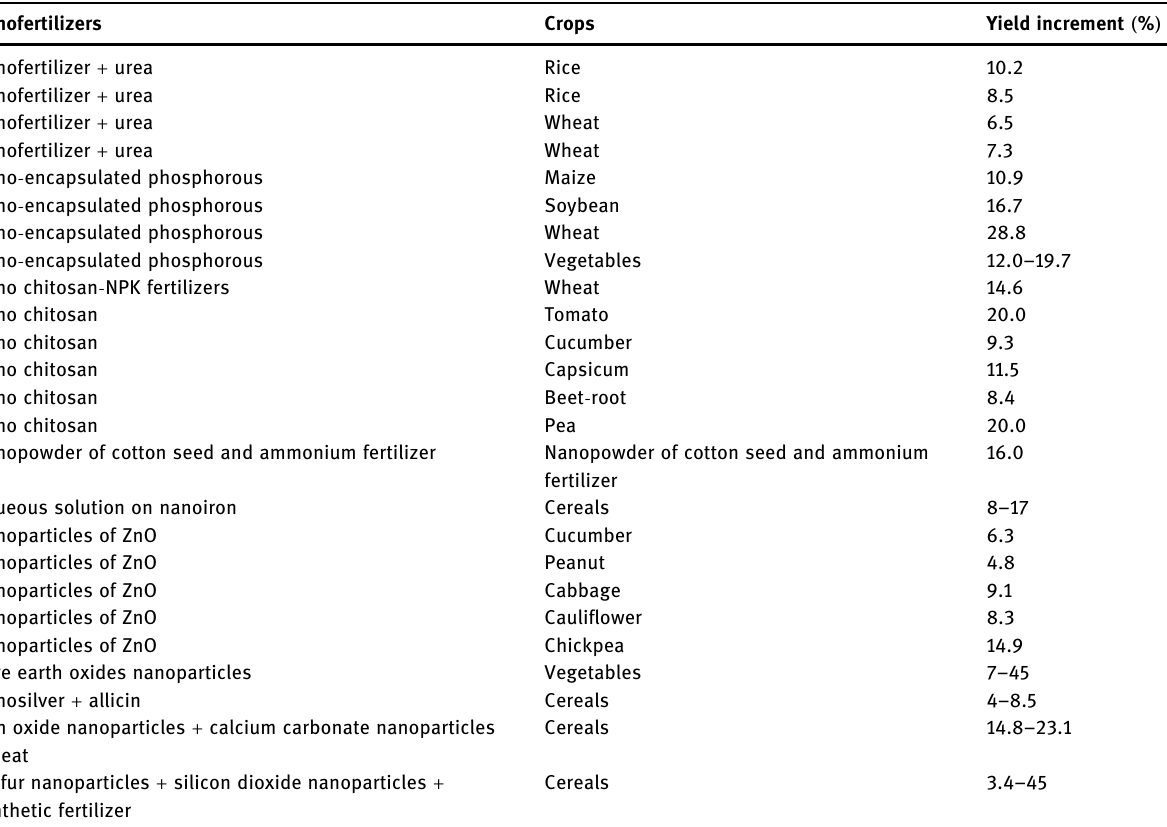
Table 2: Impact of NFs on productivity of di ff erent crops